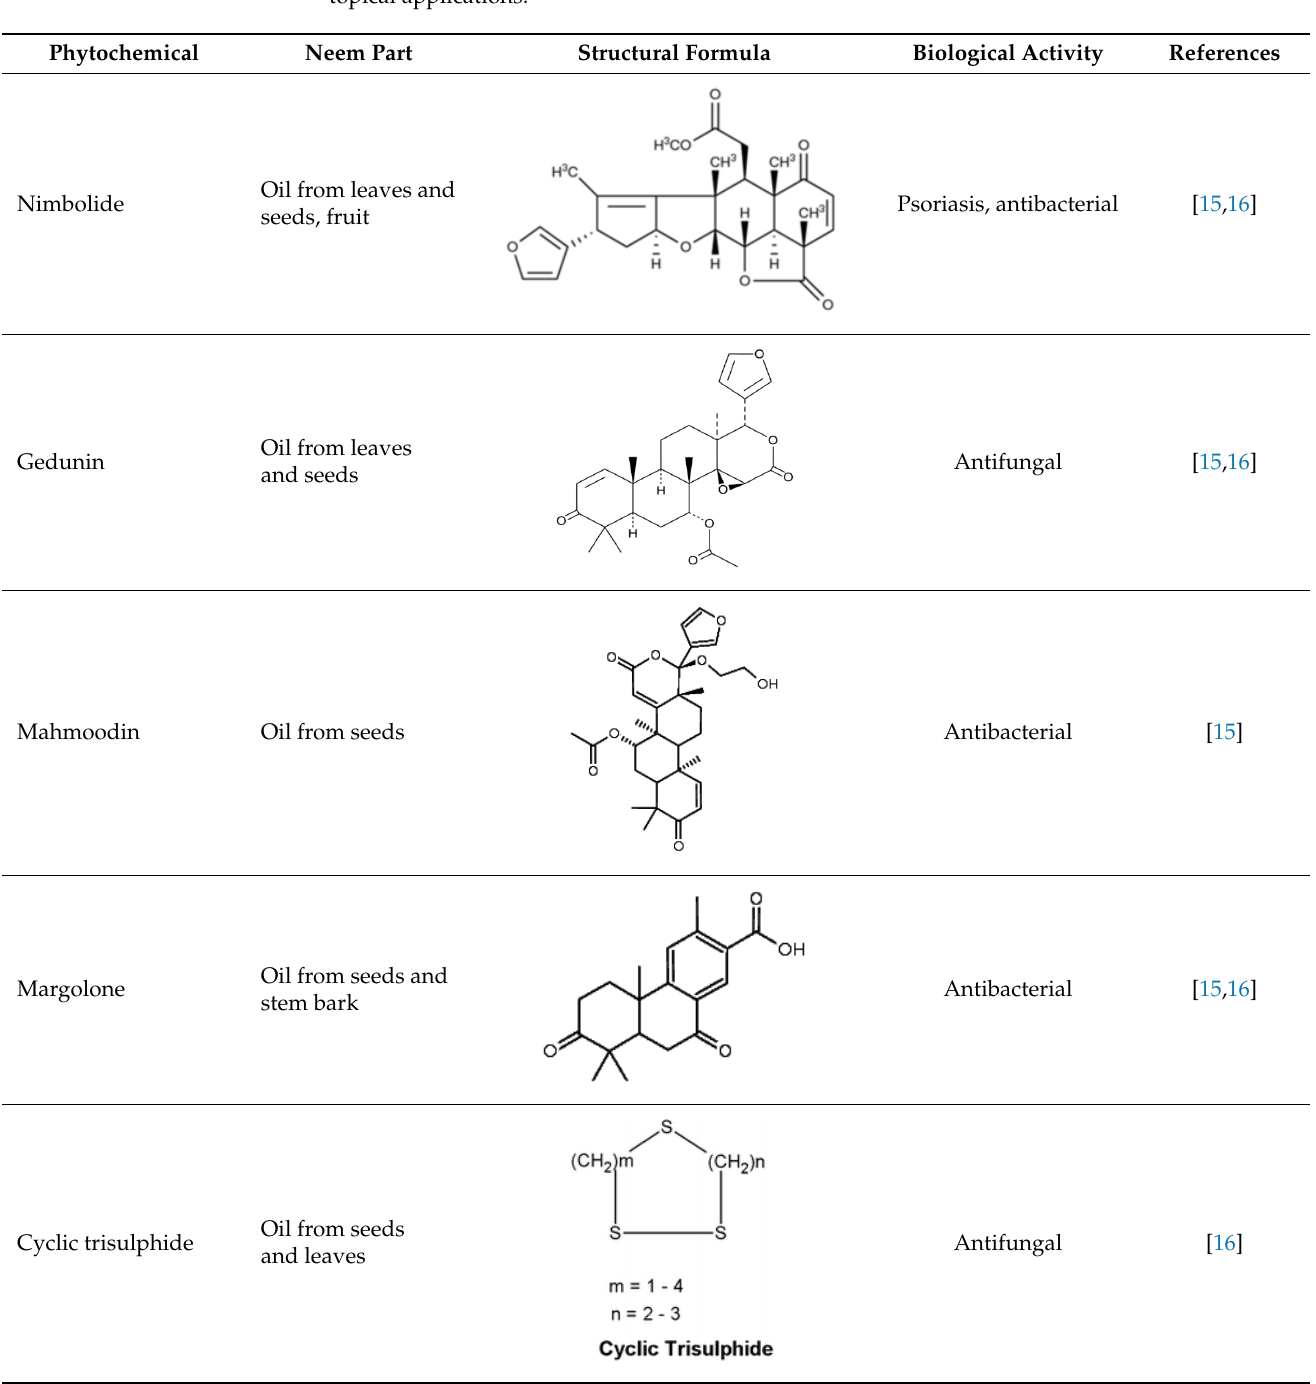
Table 1. Phytochemical structures of Azadirachta indica (Neem) parts with their cosmetic or topical applications.